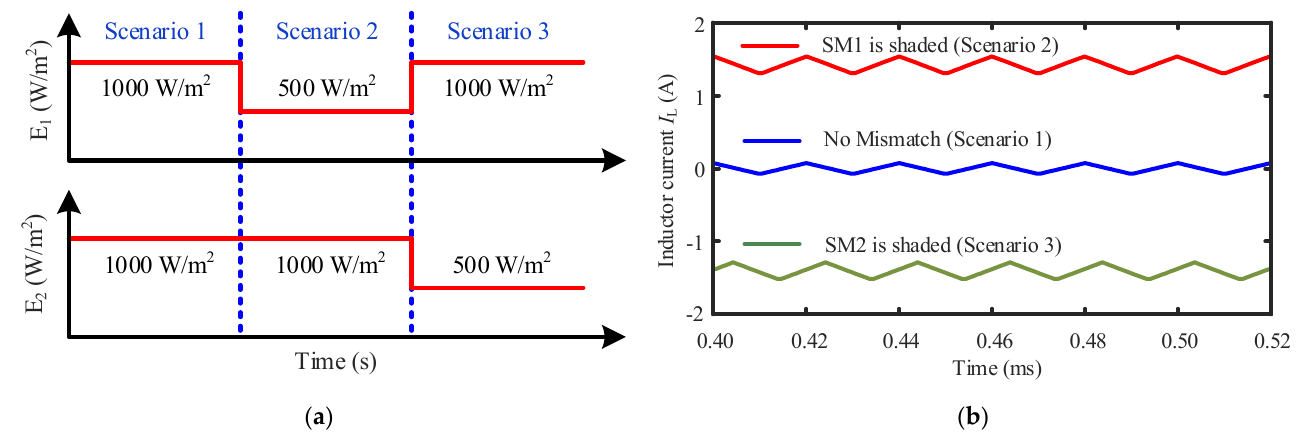
Figure 7. Mismatch scenarios and results: ( a ) Mismatch scenarios (scenario 1: when SM1 and SM2 is producing Scheme 2. when SM1 producing lower than SM2 , and scenario 3: when SM2 is producing lower than SM1 ), ( b ) Mismatch current ( I L ) passing through the inductor L under various mismatch scenarios in Figure 7a. Table 1. Ratings of the PV submodule under study.